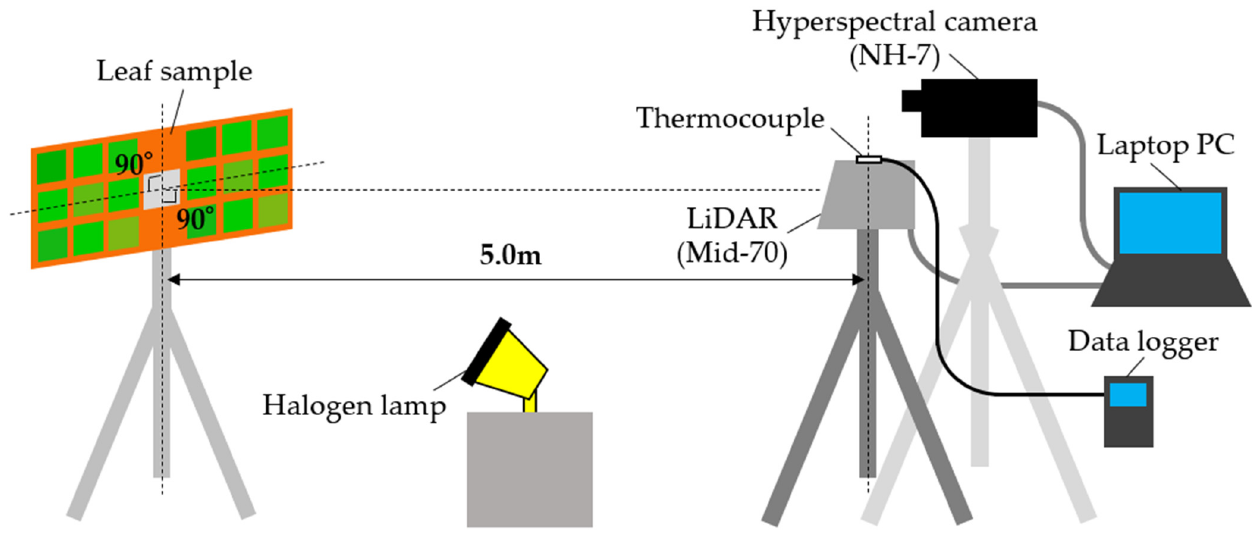
Figure 3. Schematic diagram of the